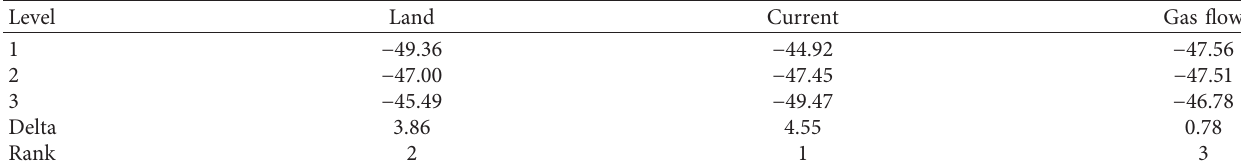
Figure 17: Load vs. displacement graph for dissimilar double V butt joint. Table 14: Taguchi analysis (residual stresses: smaller is better)—response table for signal-to-noise ratio.